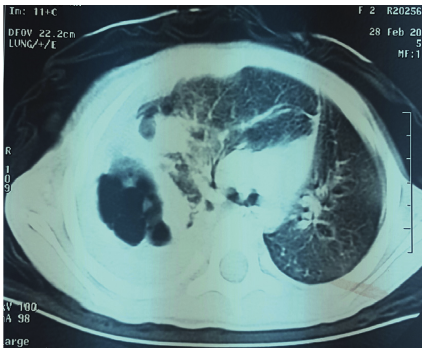
Figure 2: CTscan showing overdistension of the right chest with parenchymal air cystic lesions involving the external segment of the middle lobe.